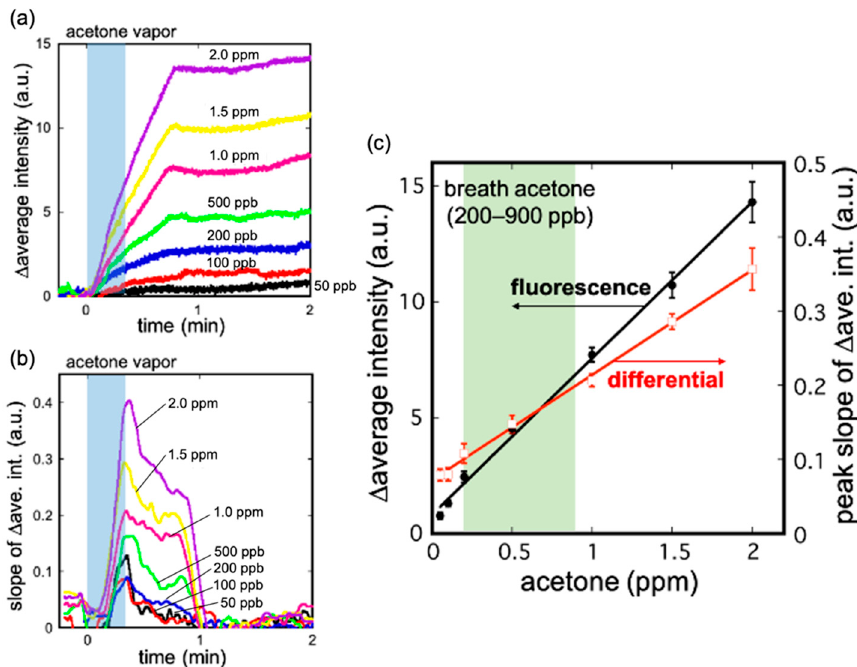
Figure 6. ( a ) Typical responses of the acetone vapor of 50 ppb, 100 ppb, 200 ppb, 1.0 ppm, 1.5 ppm, 2.0 ppm. ( b ) Differential analysis of each acetone concentration, which is calculated using a slope of the average fluorescence intensity. ( c ) Comparison of calibration formulae based on the results of fl uorescence intensity ( ● ) and di ff erential analysis ( □ ) against acetone vapor in the system.